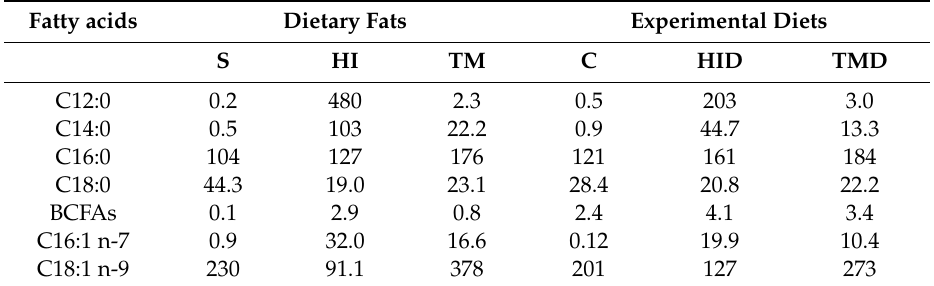
Table 2. Fatty acid profiles of the dietary fats and experimental diets (g kg-1 of total FAME) (modified from Gasco et al.